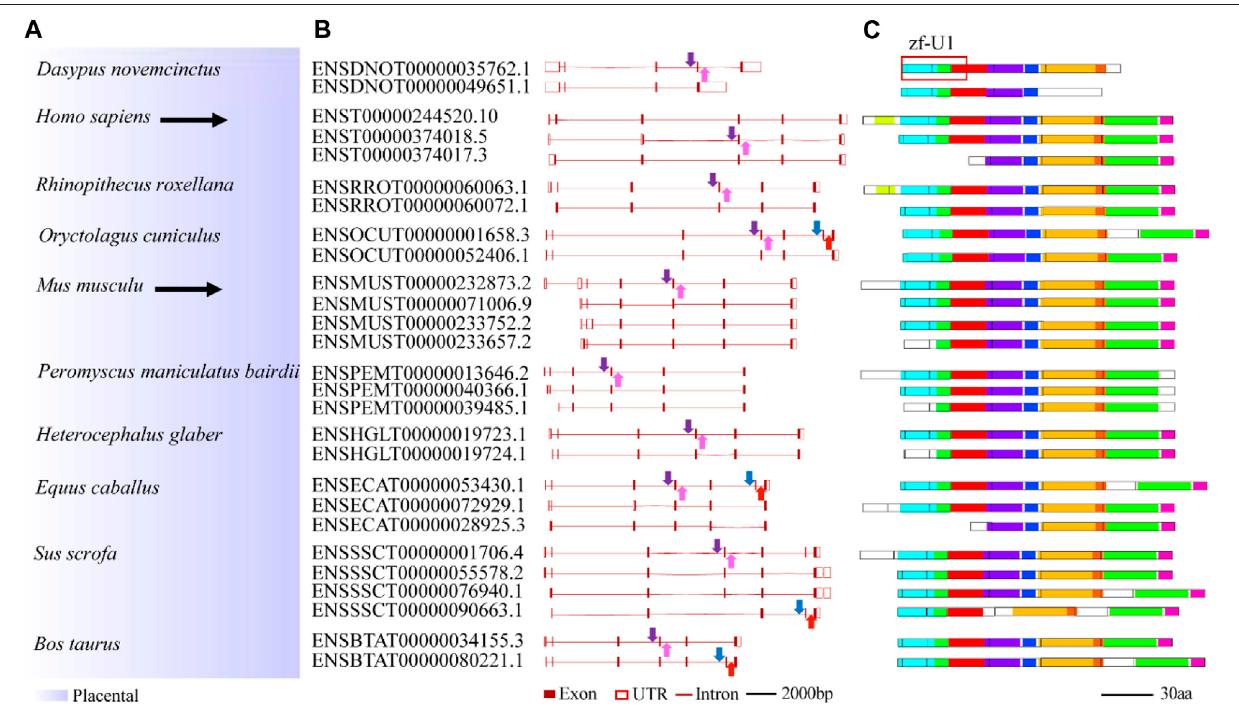
FIGURE4| Summaryofsplicingisoformsforrepresentativeanimal U1C genes.TranscriptisoformswithtranscriptIDfrom10representativeanimal U1C genesare summarized on the (A) . And their corresponding gene structures redrawn based on online ensembl were displayed on the (B) . Conserved protein motifs of potential protein products from splicing isoforms are illustrated (C) with additional annotation to de fi ne exon-exon boundaries (black lines between boxes). Solid arrows with differentcolorsrepresentdifferentconservedsplicesitesorconservedsequencesfoundincorrespondingtranscriptsbutwithoutthedetectionofparticularsplicing events. For details on the ten motifs, refer to Supplementary Figure S7 . U1C sequences from human and mouse are highlighted byblack arrow. Marked red frame on the right corner of the fi gure shows overlapped region between protein domain (zf-U1) of U1C and conserved